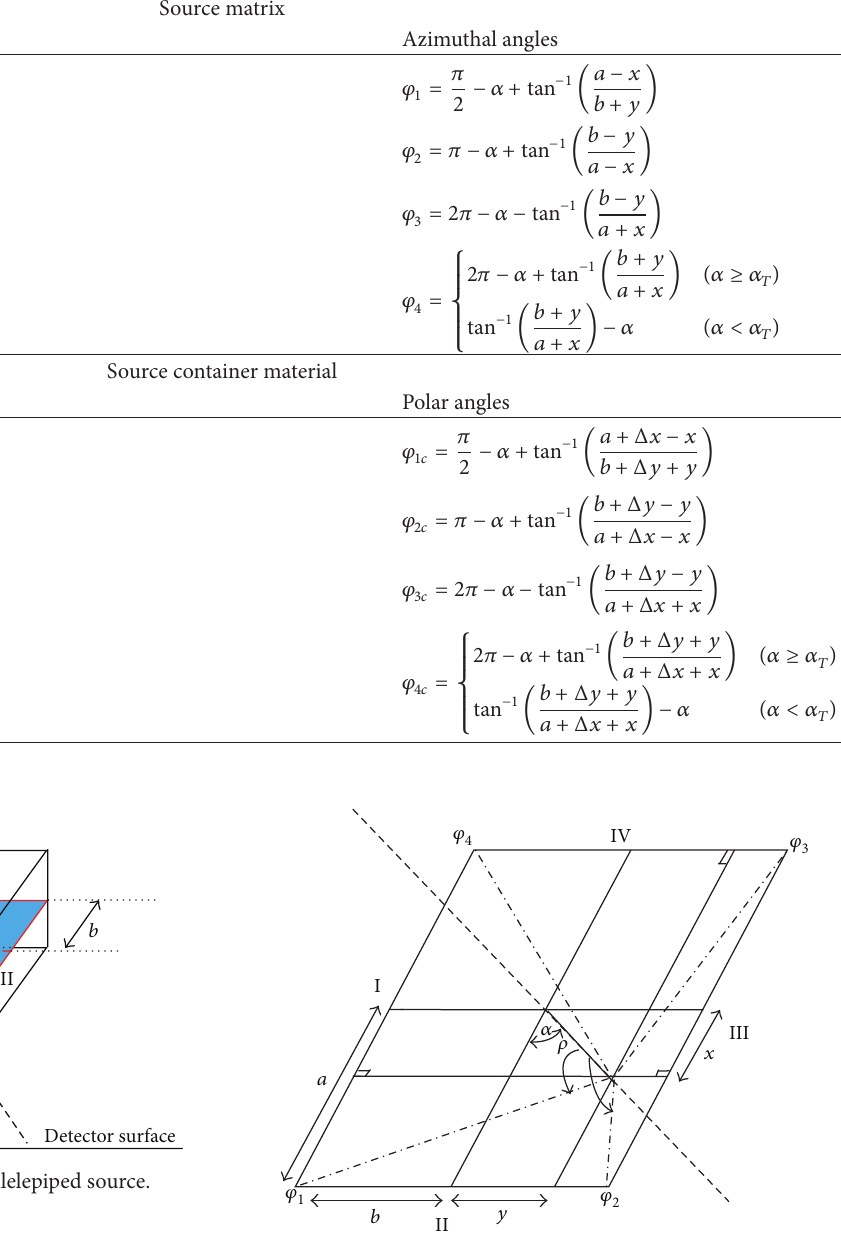
Figure 3: Schematic view for the azimuthal angle values in the bar